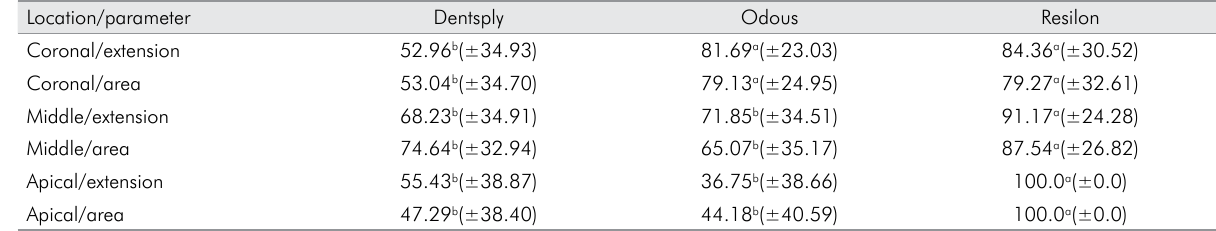
Table 2. Analysis of filling material penetration into simulated lateral canals made in each root third – photographs of decalcified and cleared specimens (mean percentages).